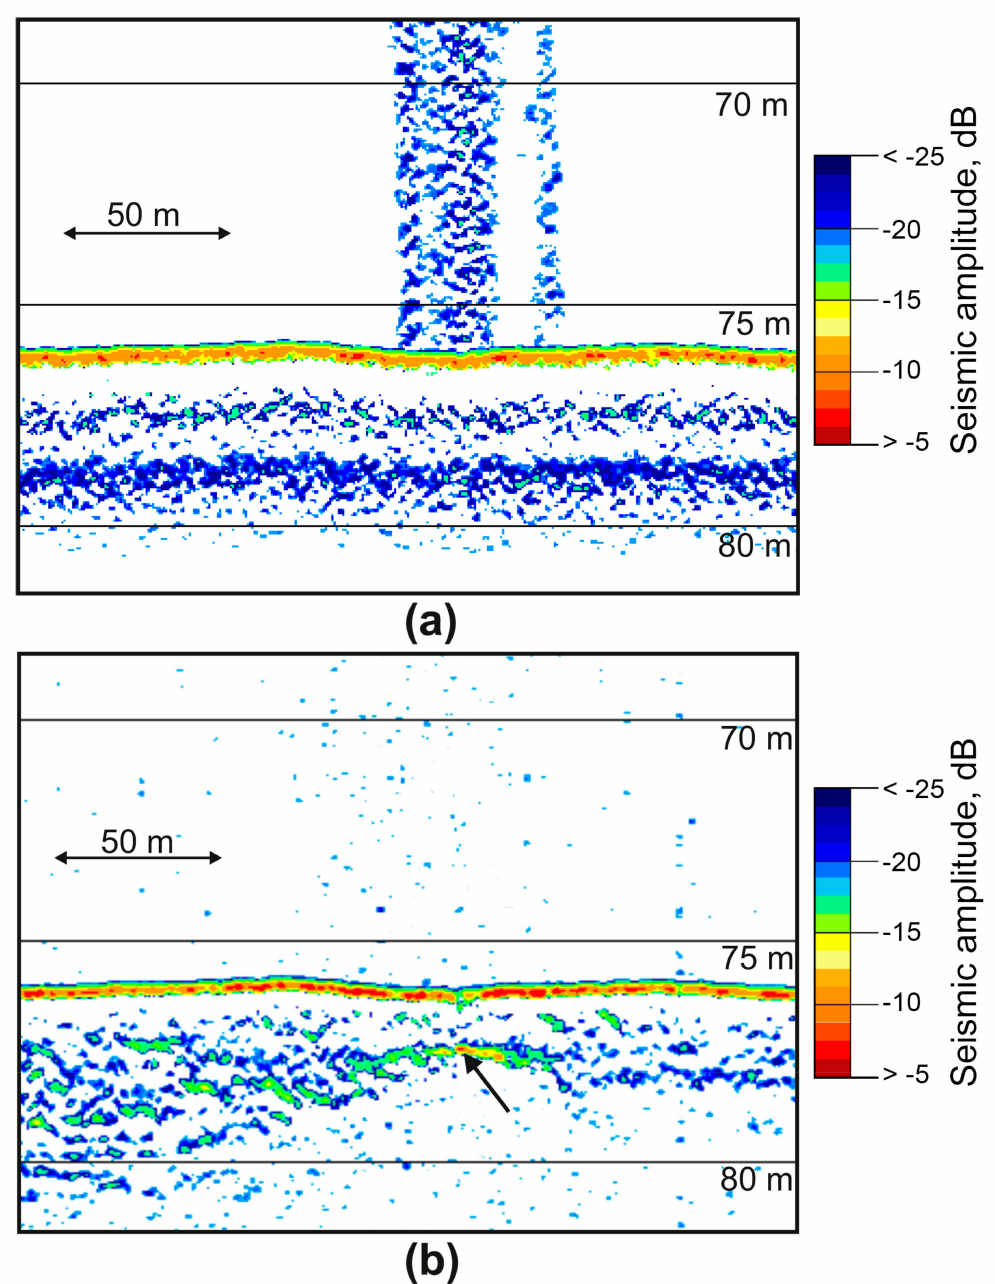
Figure 10. Simultaneous records of gas anomalies were obtained in the Laptev Sea using the high frequency ( a ) and low frequency ( b ) channels of SES-2000 Standard. The black arrow indicates enhanced